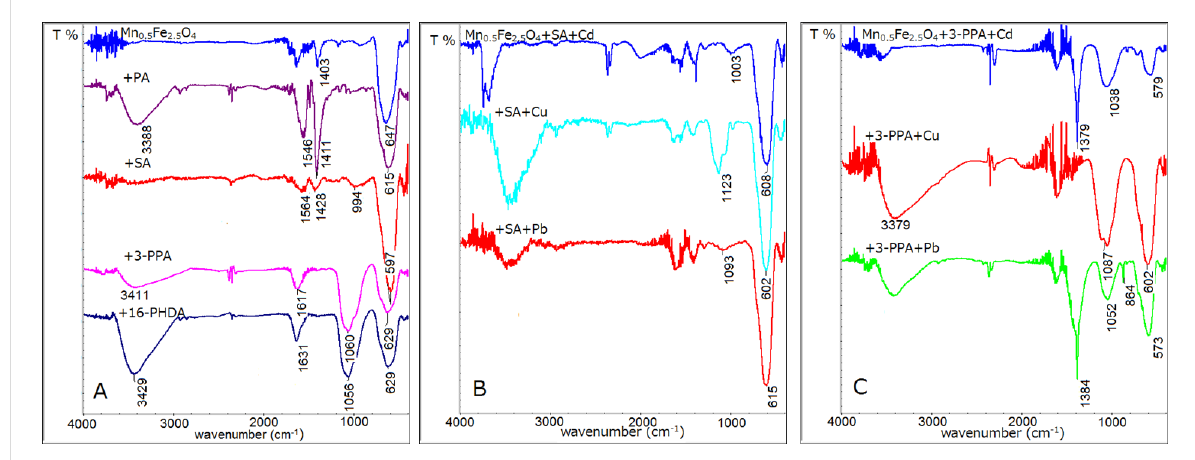
Figure 4. This core composition was selected as representative sample for the following tests. Nevertheless, all types of parti- cles were analyzed in the same